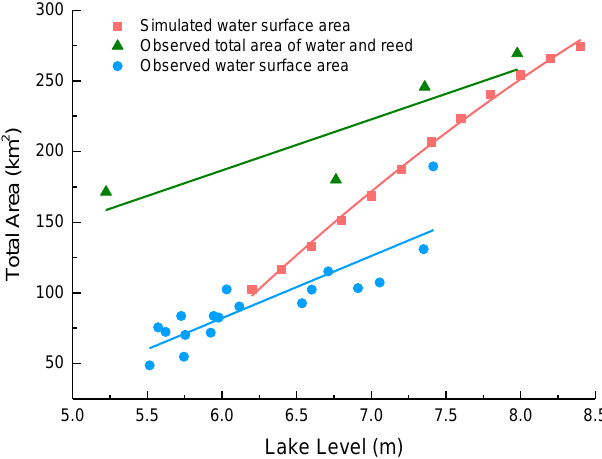
Figure 6. Relation between water surface area and lake level.